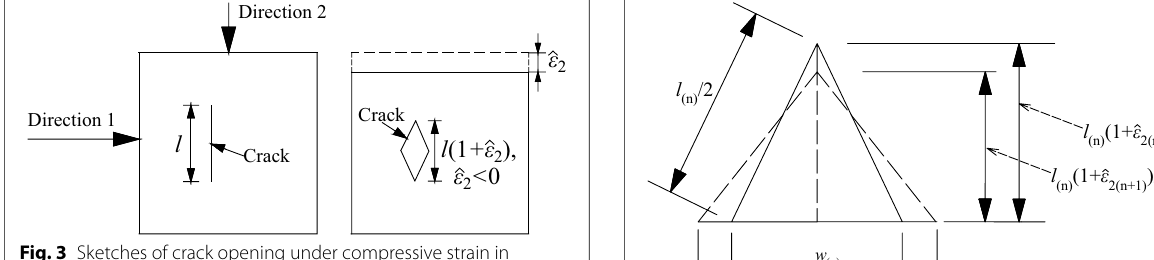
Fig. 3 Sketches of crack opening under compressive strain in direction 2.